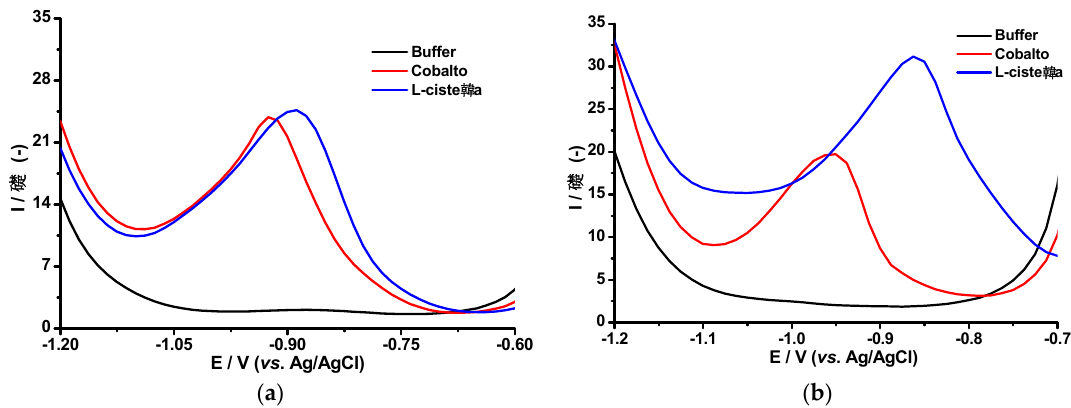
Figure 4. Differential pulse voltammetry (DPV) responses of the AgBiNpNf/Cu ( a ) and Figure 4. Di ff erential pulse voltammetry (DPV) responses of the AgBiNpNf / Cu ( a ) and AgHgNpNf / Cu AgHgNpNf/Cu ( b ) modified electrode, in 0.1 mol L − 1 ammonium chloride buffer solution, pH 9.5, ( b ) modified electrode, in 0.1 mol L − 1 ammonium chloride bu ff er solution, pH 9.5, (black curve), of the (black curve), of the Brdi č ka supporting electrolyte in the absence (red curve) and in the presence of Brdiˇcka supporting electrolyte in the absence (red curve) and in the presence of l -cysteine (blue curve), L -cysteine (blue curve), 25 mV s − 1 scan rate. 25 mV s − 1 scan rate.